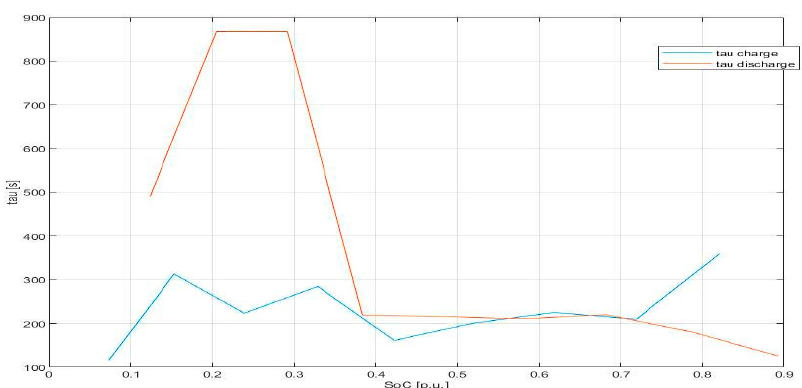
Figure 11. τ at di ff erent values of Figure 11. τ at different values of SoC.